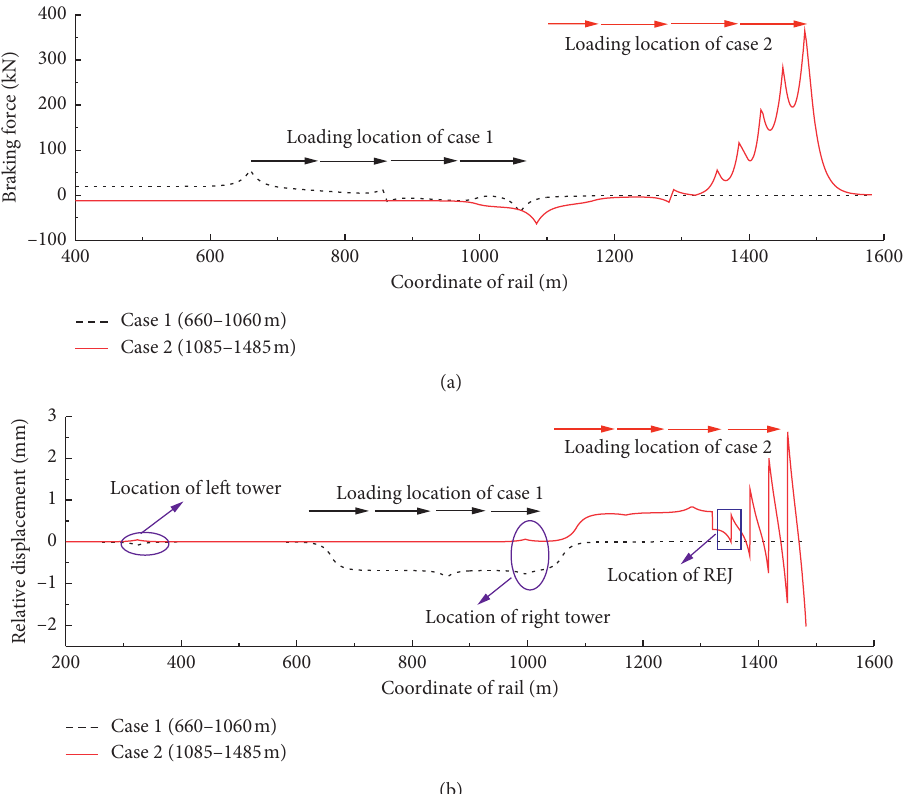
Figure 9: Braking and starting condition with REJs. (a) Rail braking force. (b) Beam-rail relative displacement.